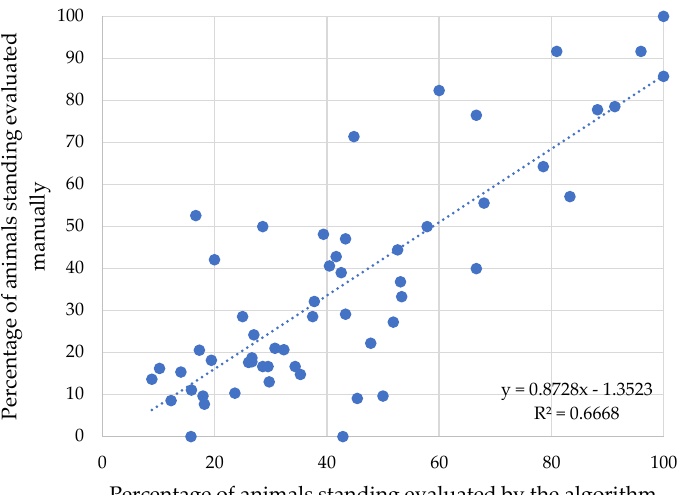
Figure 7. Dispersion for percentage of animals in manual counting versus artificial intelligence counting, for the standing behavior.